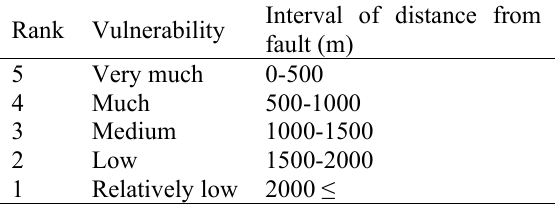
Table 2. Vulnerability and its ranking based on